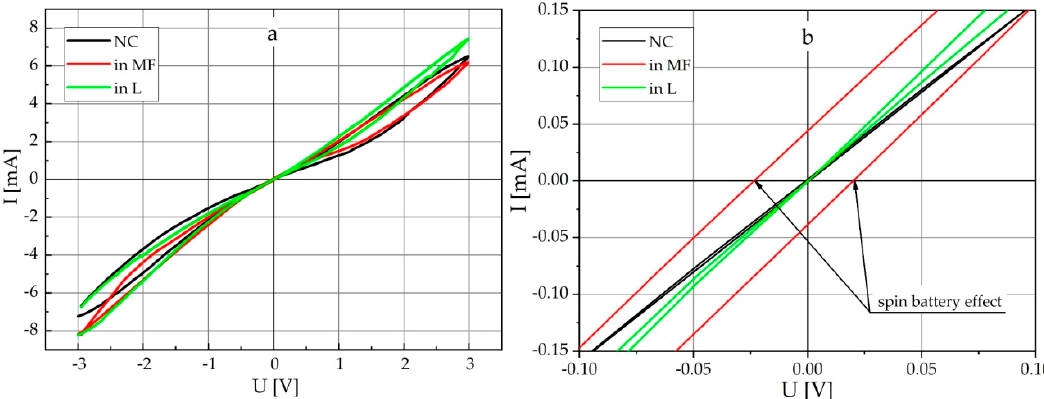
Figure 15. Current-voltage (CV) characteristics of GaSe(SC(NH 2 ) 2 (SmCl 3 )) measured perpendicularly to the layers under normal conditions (black), in the applied magnetic field (red) and under light illumination (green) ( a ). Spin battery effect: experiment under normal conditions (black), in the magnetic field H = 2.75 kOe (red) and under light illumination (green) ( b ).